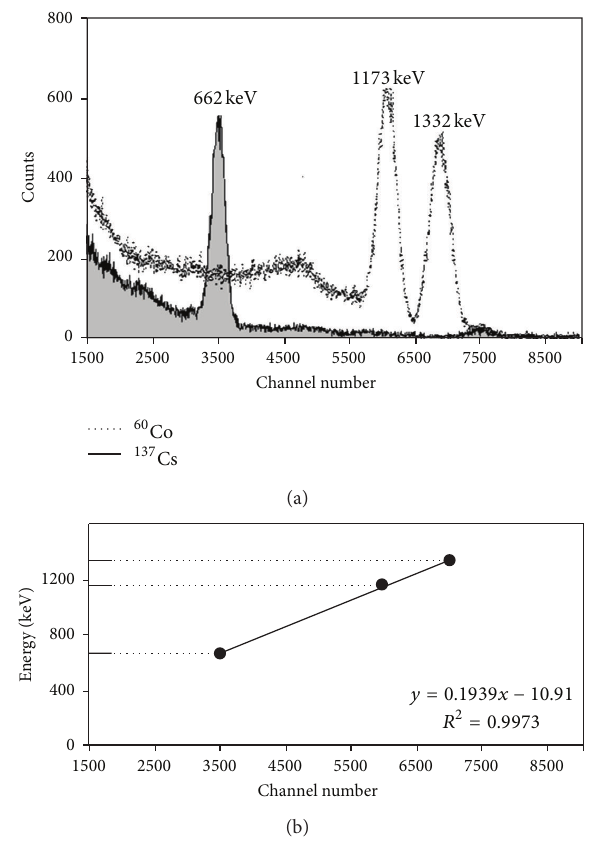
Figure 2: Calibration spectrum obtained for 137 Cs and 60 Co source (a) and related fit